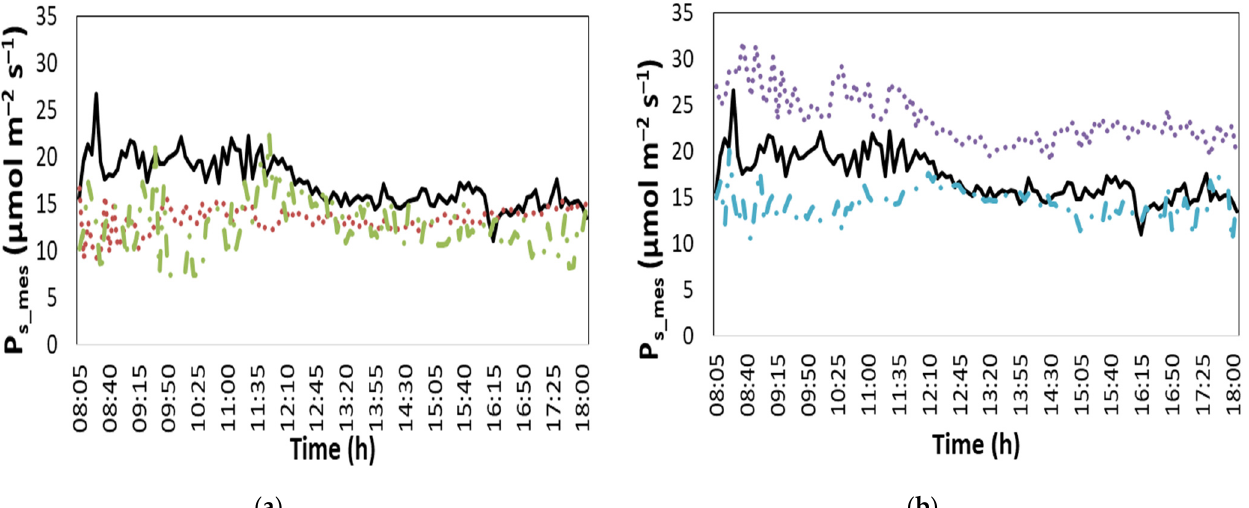
Figure 5. Daily time series of the measured photosynthesis rate on the 10th day of the 20-day reported period ( P s_mes ; μ mol m − 2 s − 1 ) ( a ) in NoS, HTS and LTS treatment and ( b ) in NoS, LNS and LWS treatment. Solid line: NoS, dot line: ( a ) LTS; ( b ) LNS, dash ‐ dot: ( a ) HTS; ( b ) LWS.